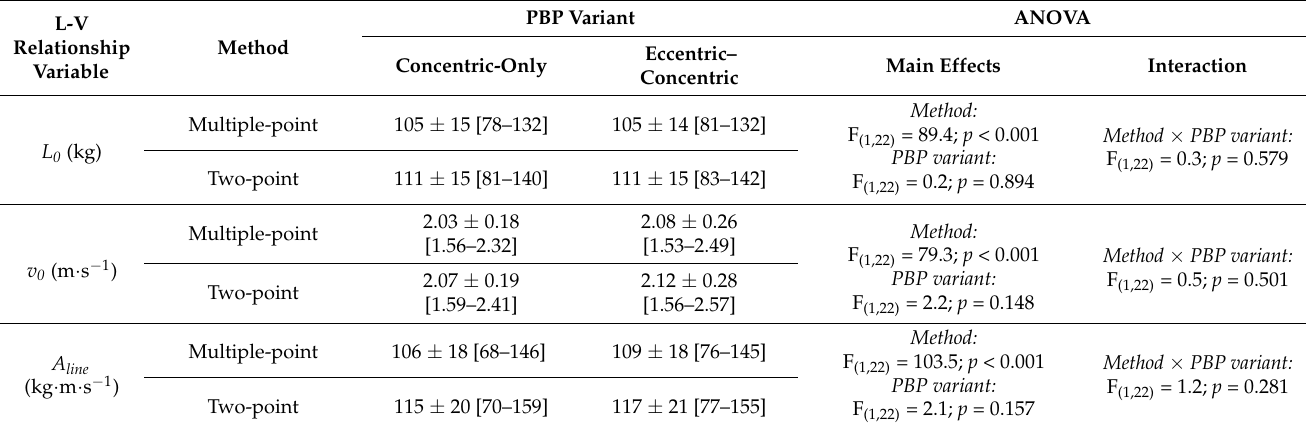
Table 1. Two-way repeated-measures analysis of variance (ANOVA) comparing the load–velocity (L-V) relationship variables between the methods and prone bench pull (PBP)